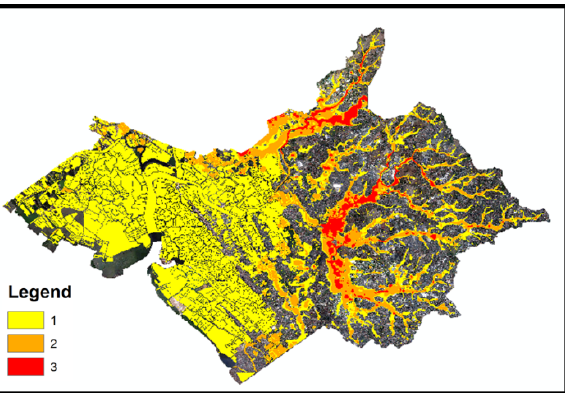
Figure 8. 2020 Hazard Map